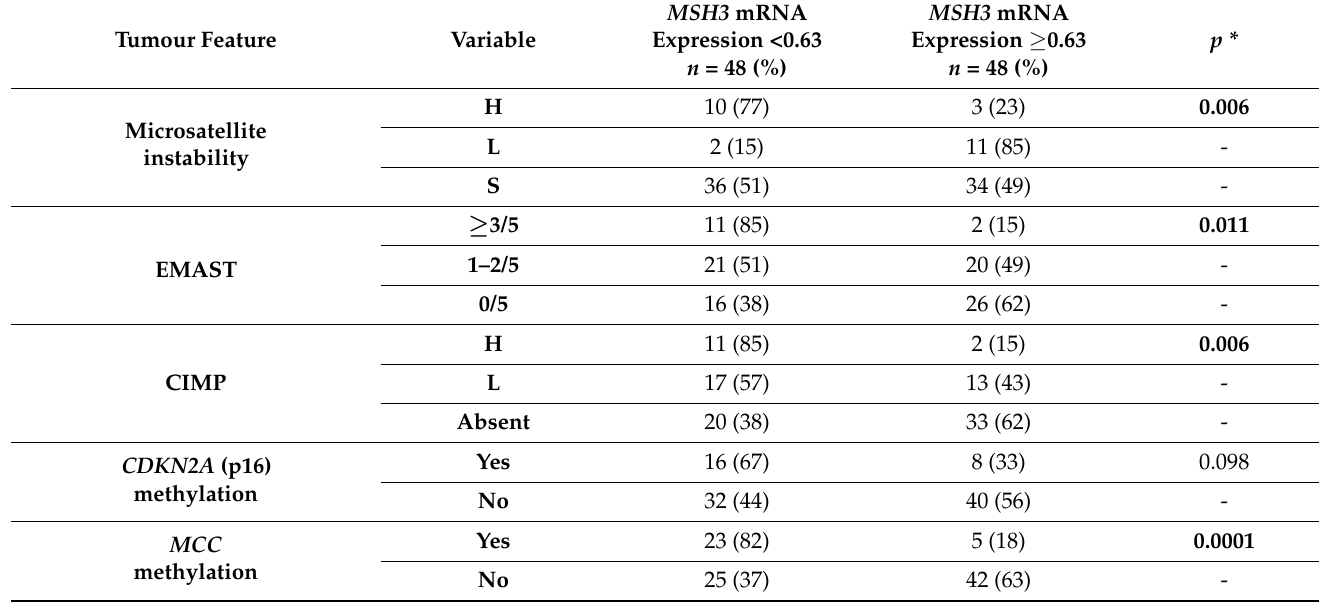
Table 3. Association of MSH3 mRNA expression with MSI, EMAST and gene promoter methylation in sporadic colorectal cancers (cohort 1). Tumour MSH3 expression is shown relative to matched normal tissue and grouped according to median expression